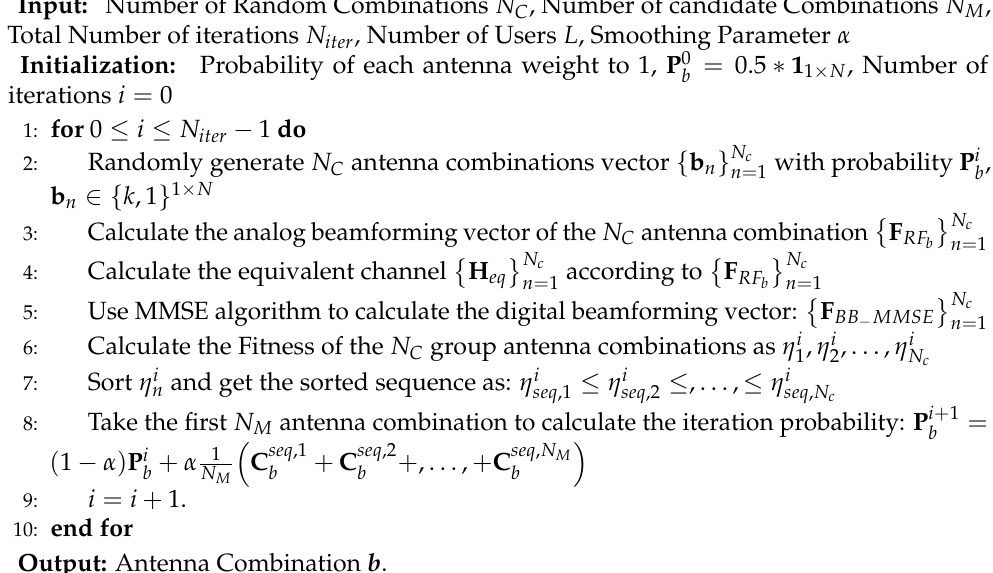
Algorithm 2 Hybrid Beamforming Scheme Based on Cross-Entropy Iterative Algorithm.